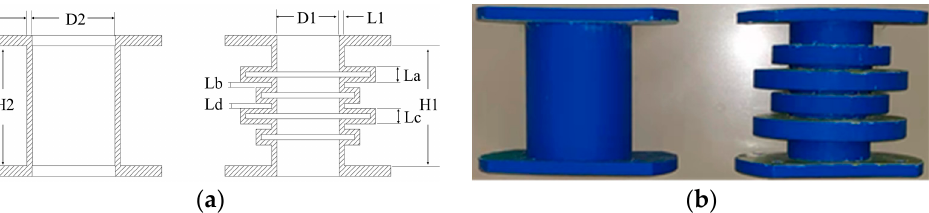
Figure 3. Schematic diagram and reality of specimens. ( a ) Schematic diagram of the structure of the two specimens, ( b ) the two different specimens.